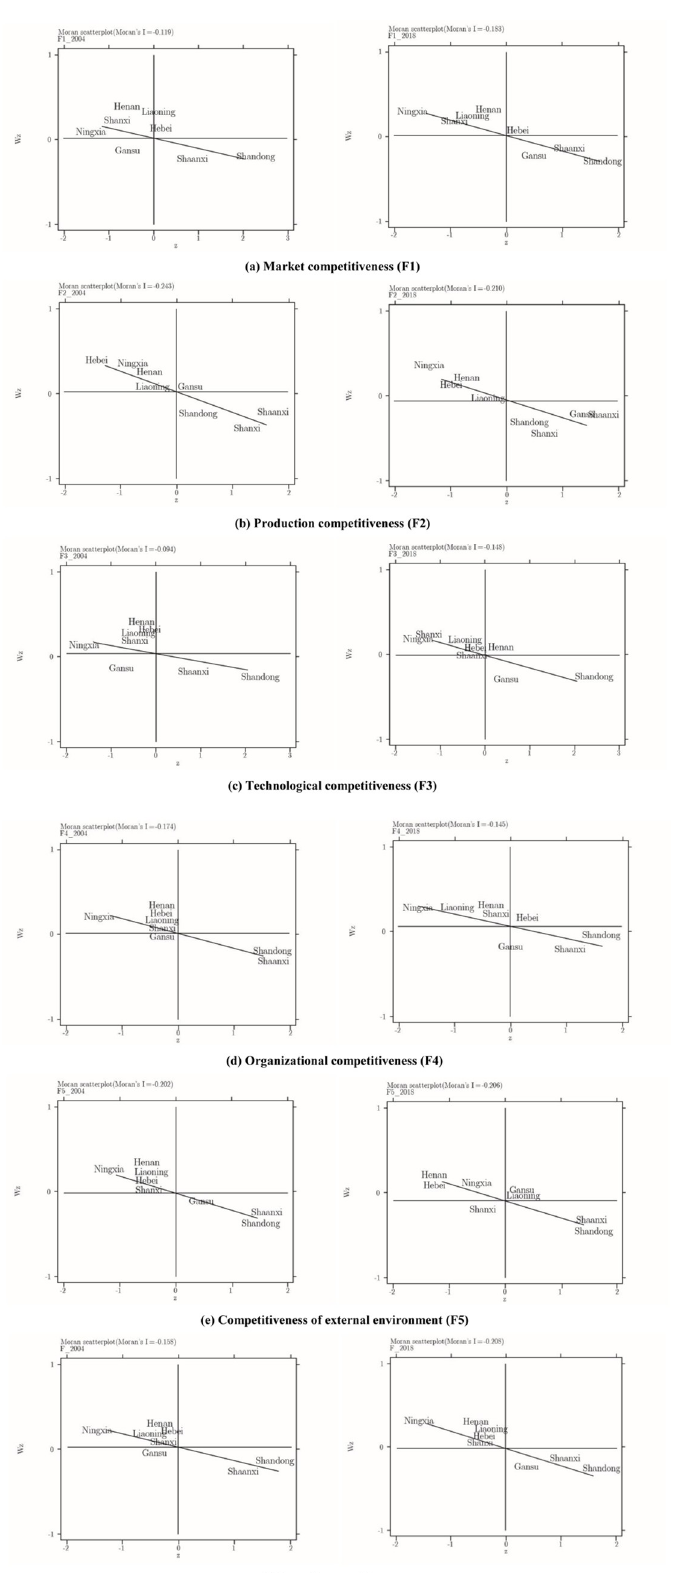
Fig 1. Scatterplots of core variables of competitiveness in 2004 and 2018. https://doi.org/10.1371/journal.pone.0268476.g001 PLOS ONE | https://doi.org/10.1371/journal.pone.0268476 June 1,